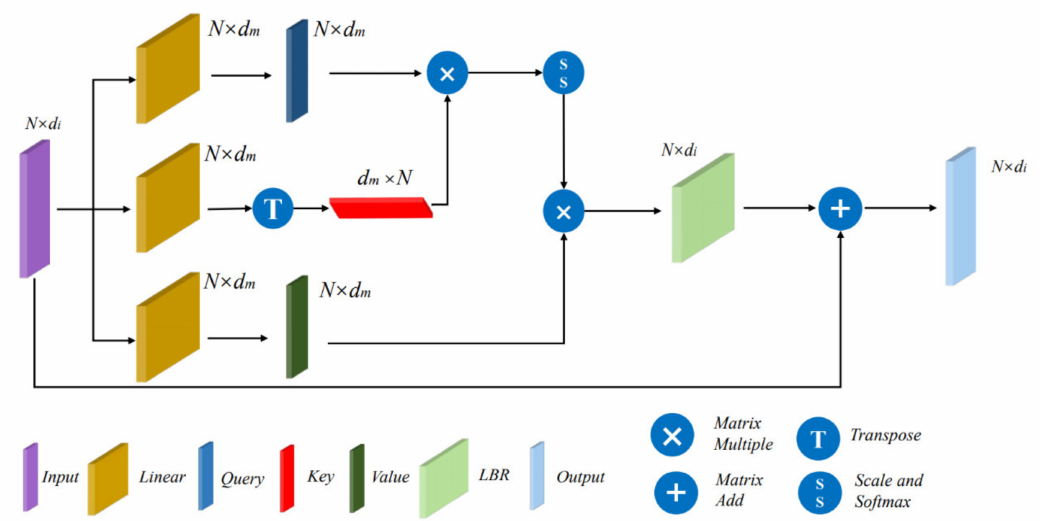
Figure 3. The structure of scalar attention